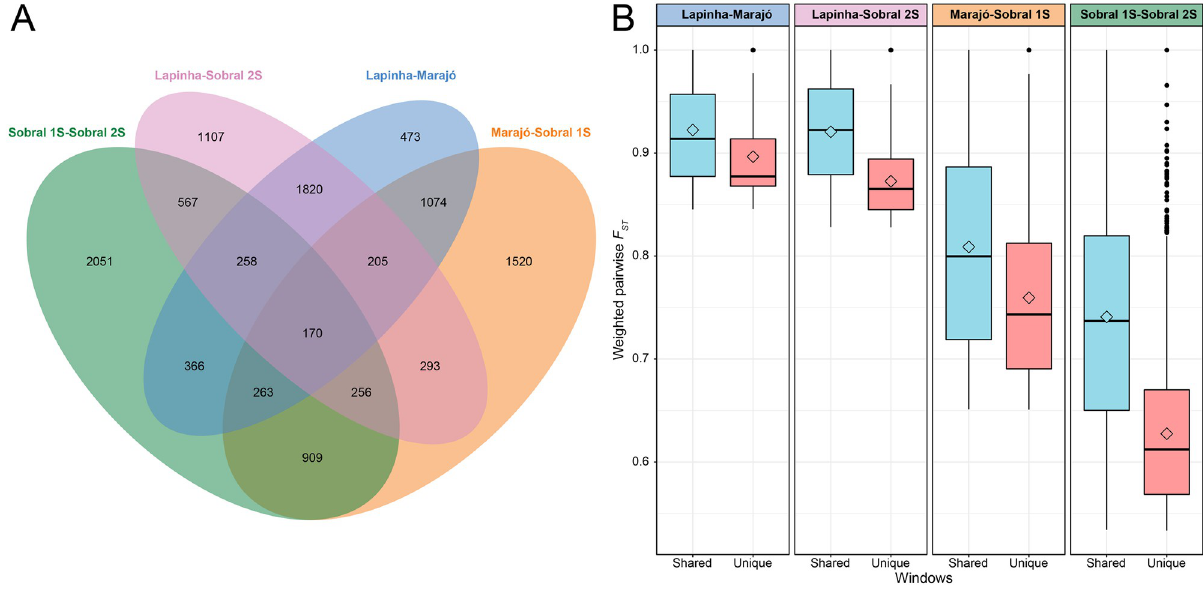
Fig 4. Genomic regions with high pairwise F ST between the different populations of Lutzomyia longipalpis . (A) Venn diagram depicting the number of 1 kb non-overlapping genomic windows having F values in the top 2.5% quantile (outlier) among the different population comparisons. ST (B) Box plots of outlier F ST windows shared with another population comparison (blue) or unique to a population comparison (pink). Box plots show the medians (lines) and interquartile ranges (boxes); the whiskers extend out from the box plots to 1.5 times the interquartile range, and values outside this limit are represented by dots. Mean F ST values are represented by open